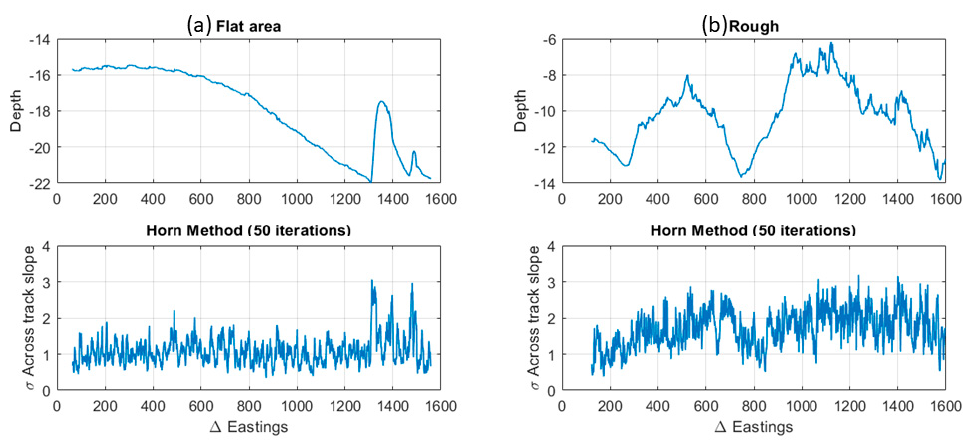
Figure 14. Results of the iteration of 50 slope estimation runs by perturbing the vertical uncertainty of a CUBE grid with a grid cell size of 1 m using the Horn method. ( a ) For the flat area; depth (top) and across-track slope standard deviation (bottom). ( b ) For the rough area; depth (top) and across-track slope standard deviation (bottom). Locations of the depth profile shown in Figure 13.